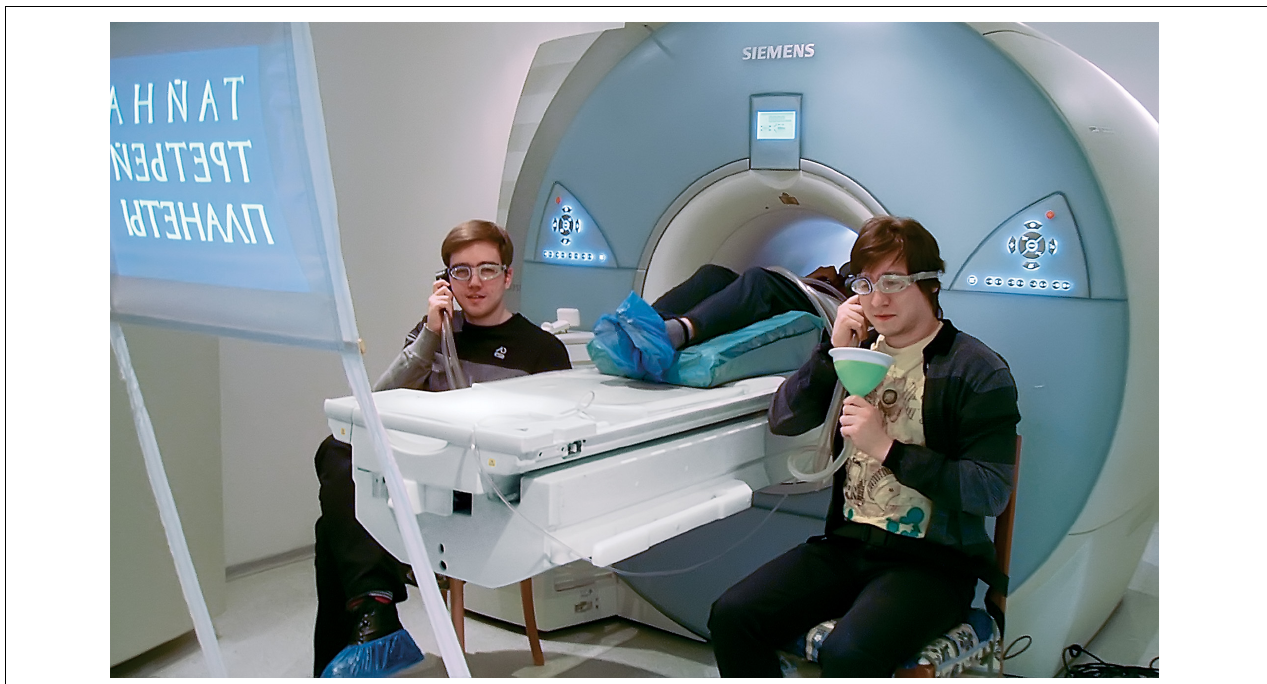
FIGURE 3 | Three members of one of the intellectual sports teams use an MR-compatible communicator system within the setup for the main experiment. The photograph is published with the permission of the participants.